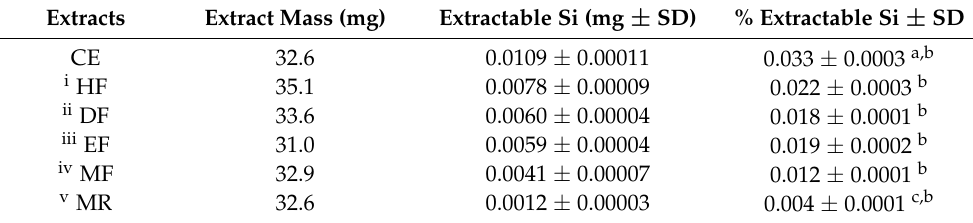
Table 2. Extractable silicon contents from E. debile tissues. Extracts